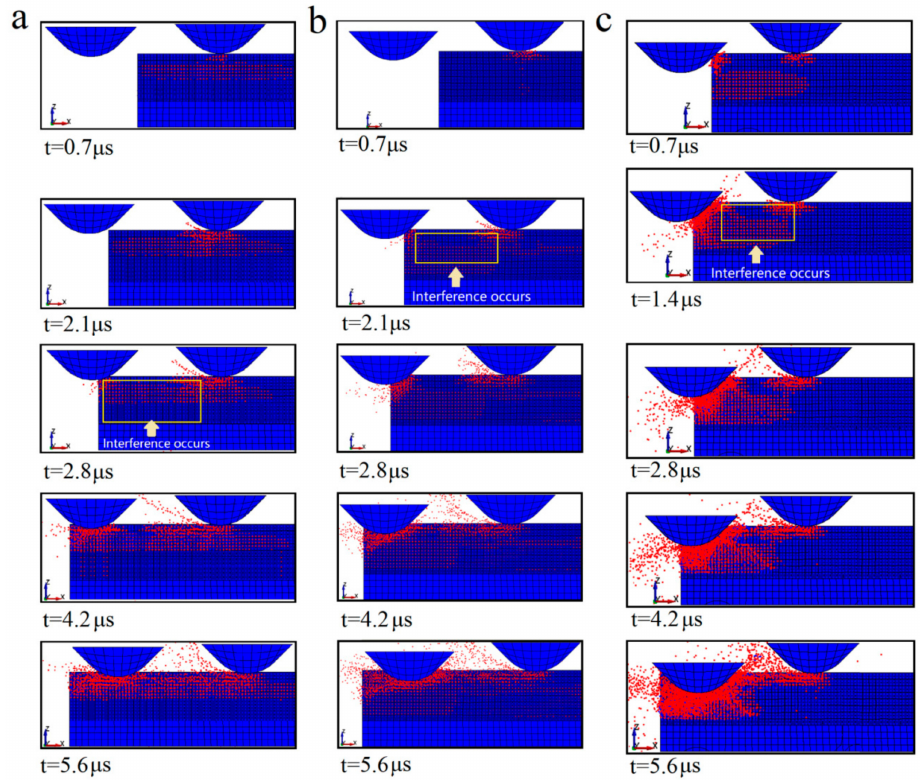
Figure 5. Damage Interference nephograms of two grit scratching of single crystal SiC with a Z-axis spacing along the DOC direction at di ff erent times, ( a ) ∆ d z is 5 µ m, ( b ) ∆ d z is 15 µ m, and ( c ) ∆ d z is 25 µ